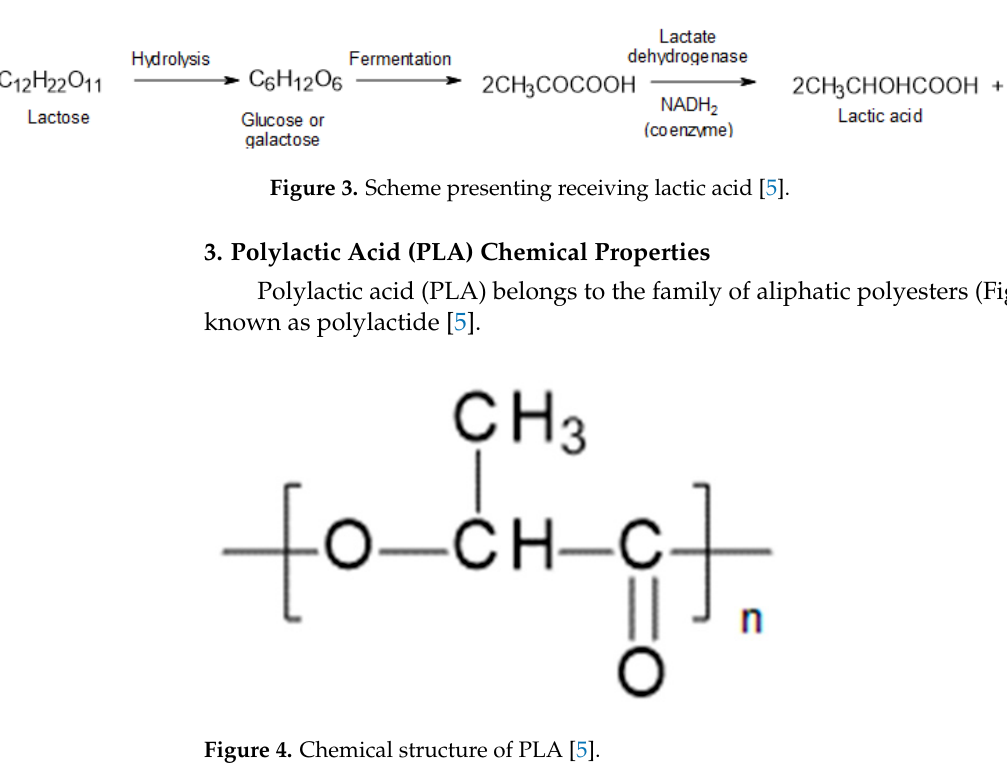
Figure 4. Chemical structure of PLA [5].